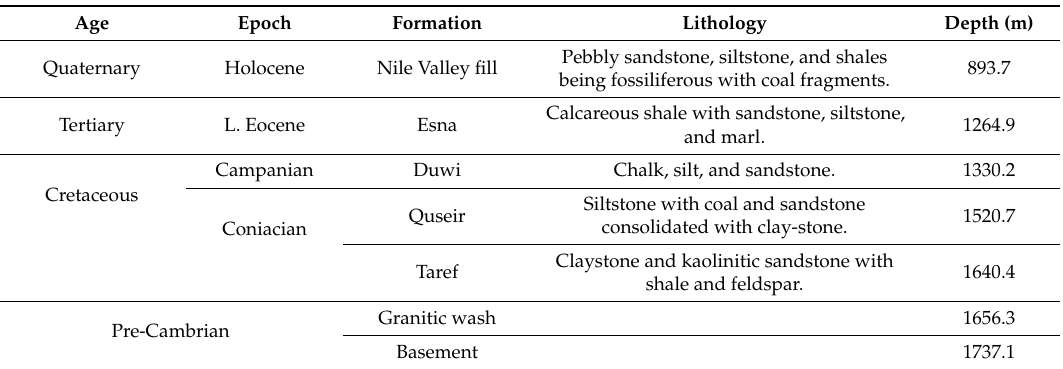
Table 1. Lithology of the Balyana-1